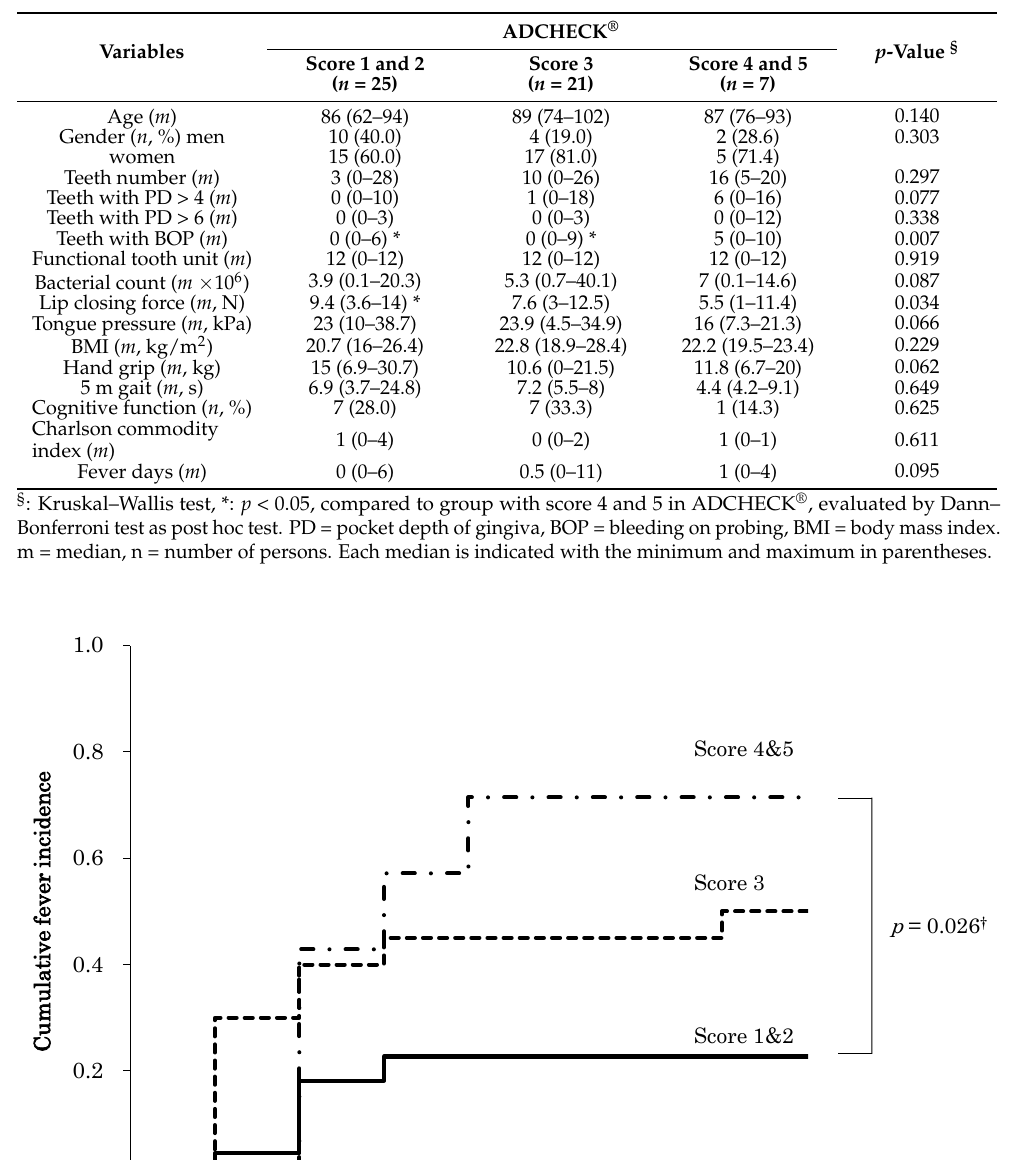
Table 3. Cox’s hazard analysis for onset of fever among groups based on ADCHECK ® scores .